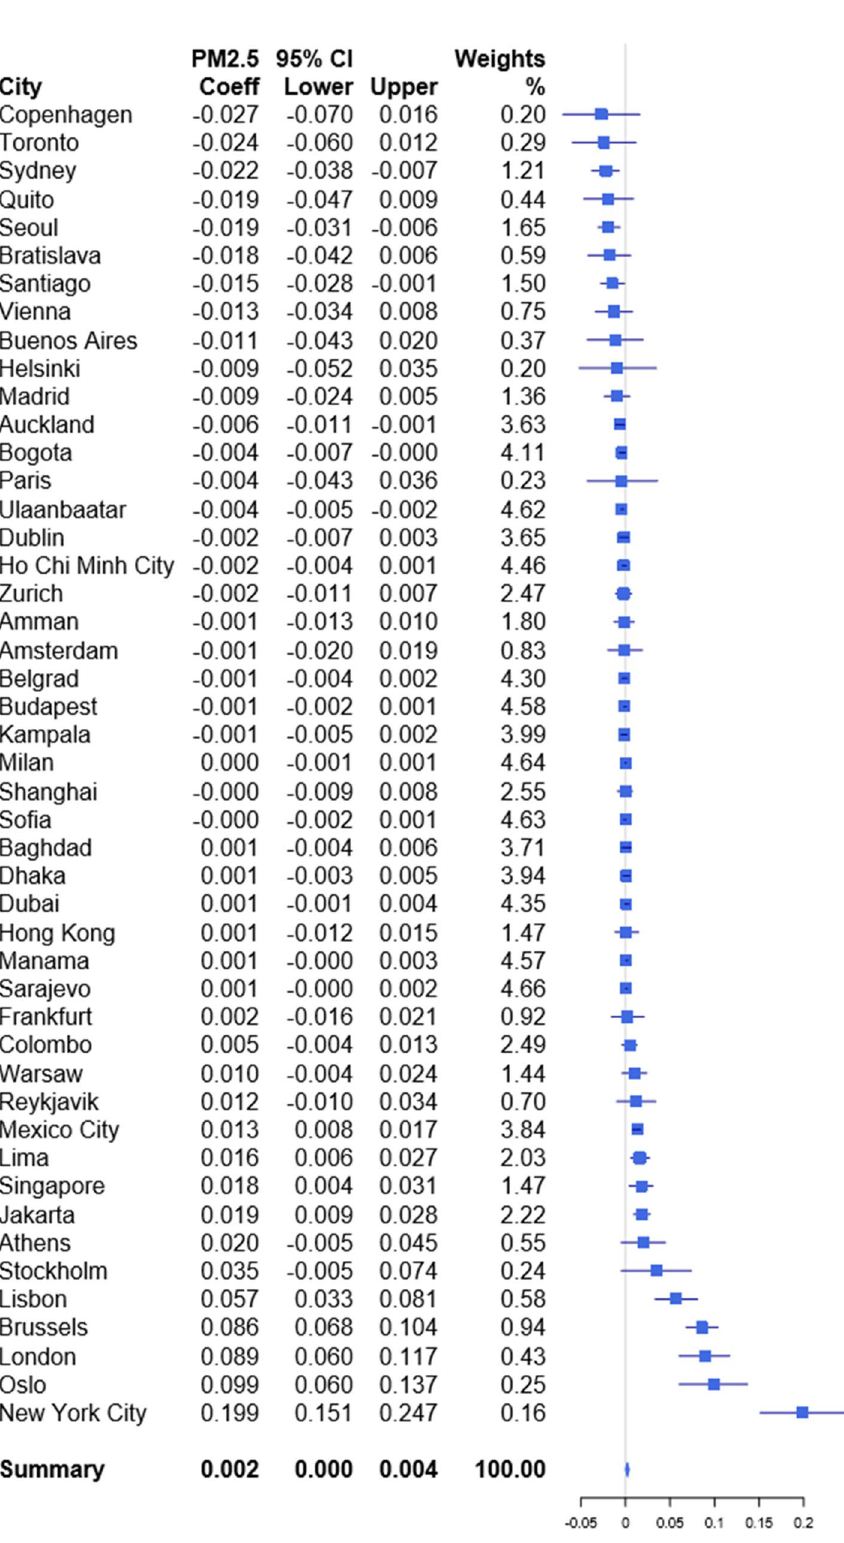
Figure 2. Regression coefficients and 95% confidence intervals for the association between 10 μg/m 3 increase in daily PM 2.5 concentration and stock index